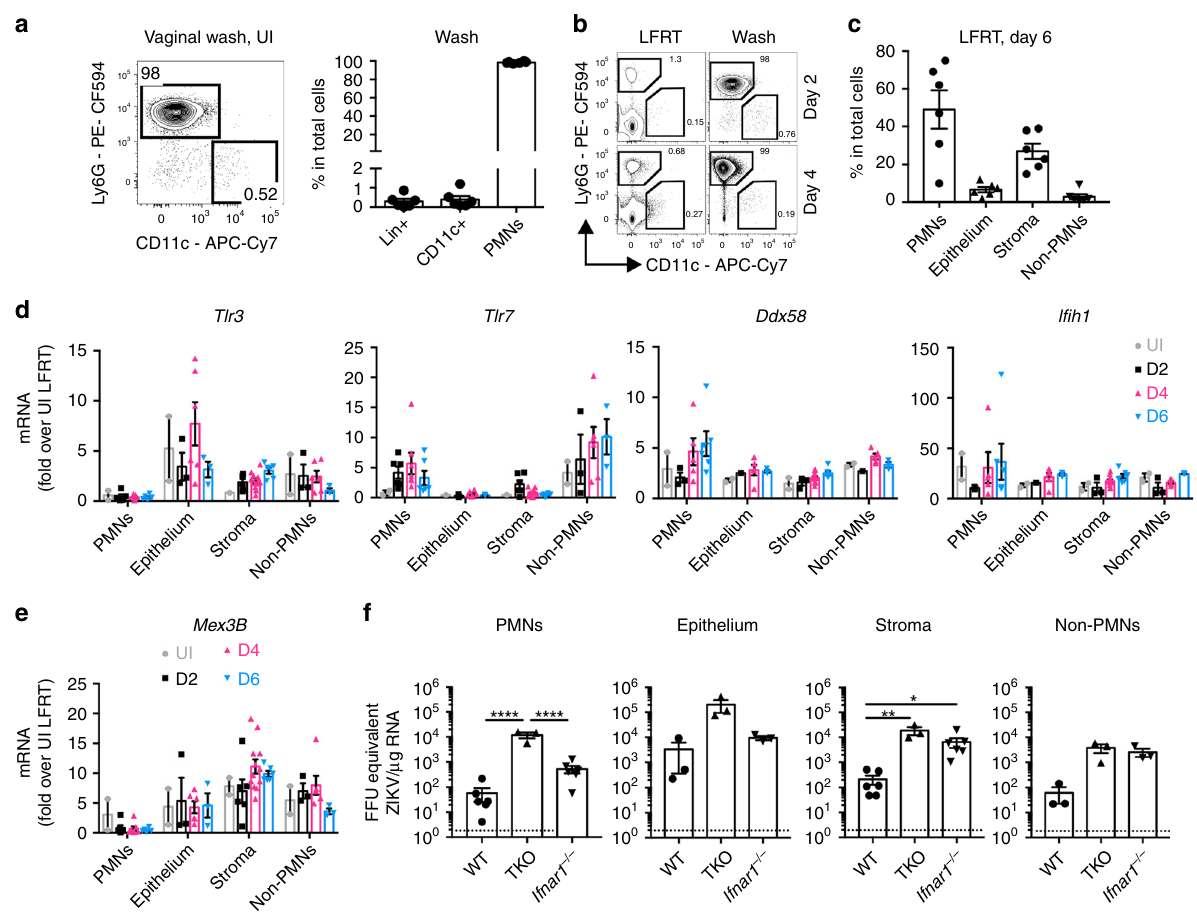
Fig. 6 Compartmentalized role of viral sensing and IFNAR signaling in the LFRT. a Cells from the vaginal lumen of DMPA-treated uninfected C57BL/6N female mice were analyzed by fl ow cytometry. In the vaginal wash, frequencies of lineage positive (Lin + : CD19 + TCR β + NK1.1 + ), DCs (CD11c + : CD19 − TCR β − NK1.1 − IAIE + CD11c + ), and polymorphonuclear neutrophils (PMNs: CD19 − TCR β − NK1.1 − Ly6G + CD11b + SSC − ) are also shown. Data represent one of four independent experiments with similar results, n = 6 mice. b Representative fl ow cytometry plots showing the abundance of Ly6G + cells in the vaginal lumen (wash) compared with the LFRT tissue, at days 2 and 4 post vaginal infection with ZIKV. c Frequency of the four different sorted